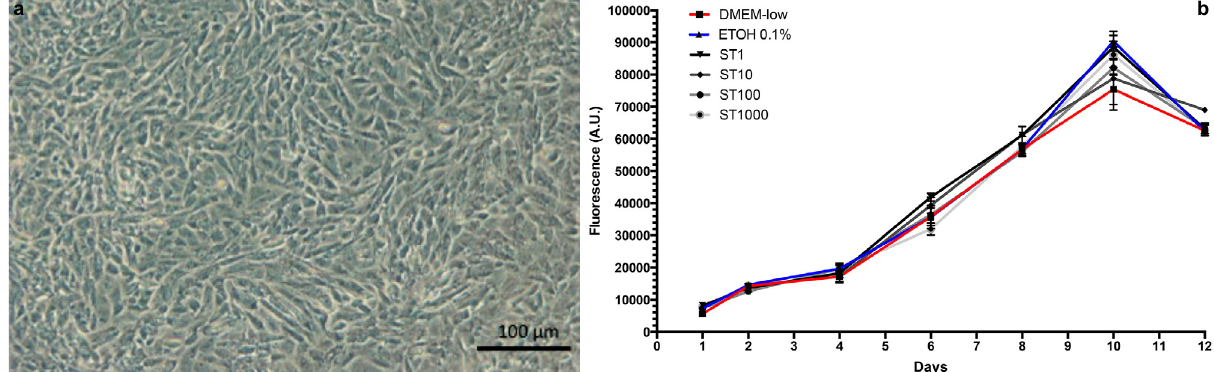
Figure 2- (a) Aspect of SaOS-2 cells at confluency. Optical microscopy, 10X magnification; (b) Graphic representation of SaOS-2 growth under different conditions: DMEM-low (red line), ETOH 0.1% (blue line), ST 1-1000 nM (shades of grey). The X axis represents the days of culture, whereas the Y axis reports fluorescence values expressed in arbitrary units